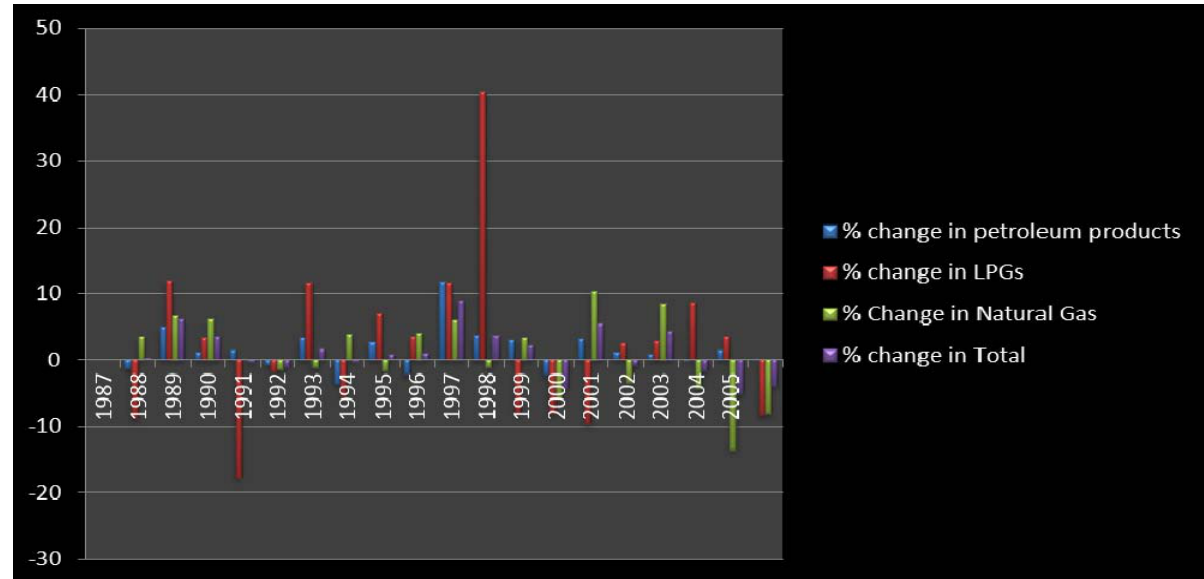
Figure 6. Graphical Summary of the Percentage of